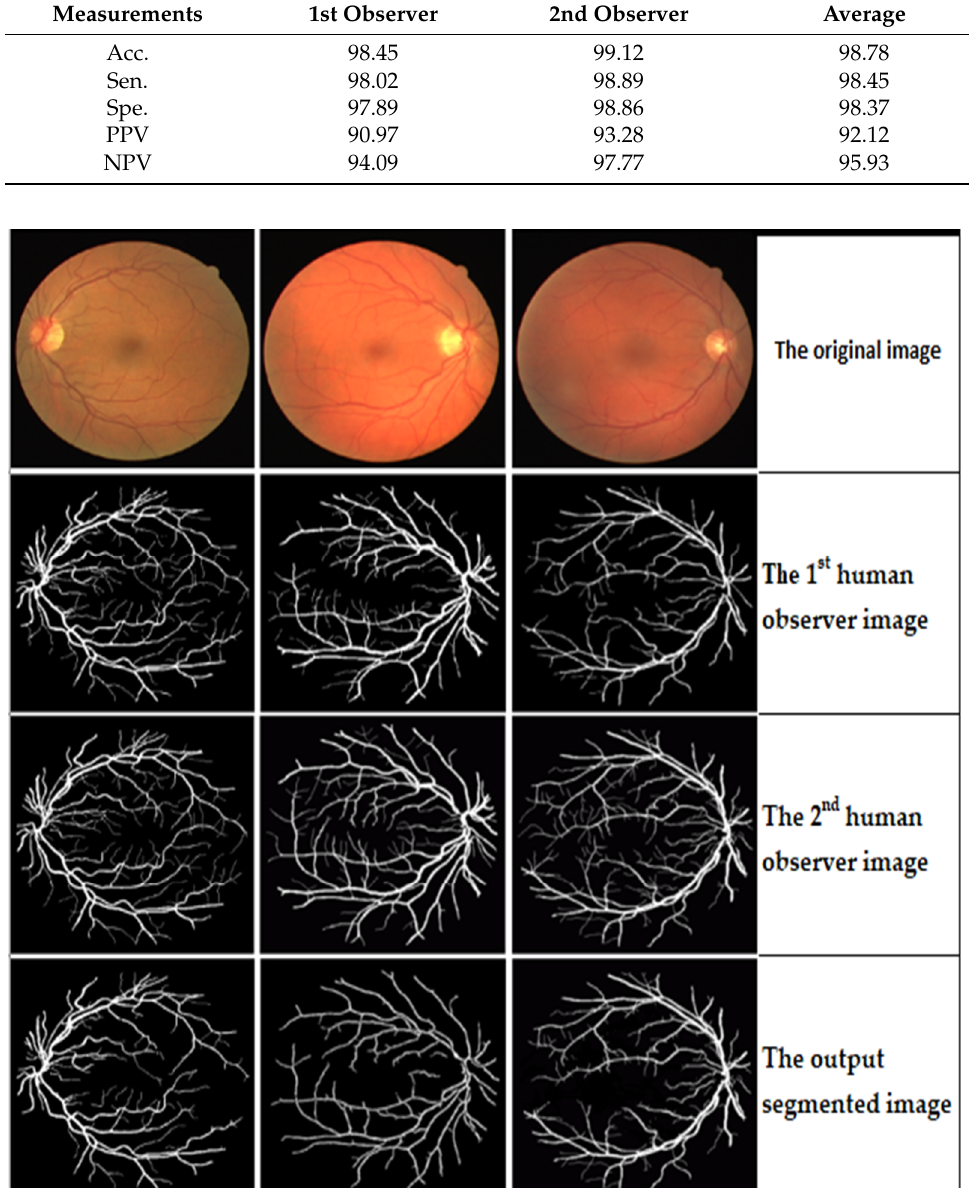
Figure 12. The output segmentation results of the proposed trainable filtering algorithm on the DRVIE dataset.